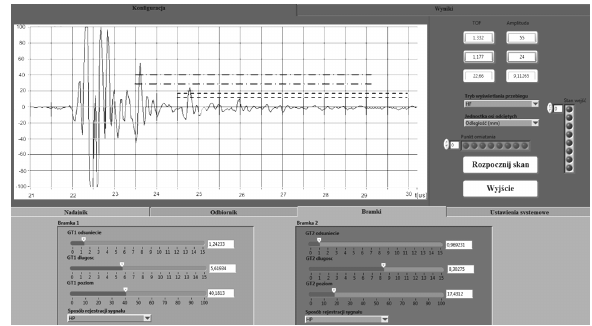
Figure 6: Measurement software: user panel view.